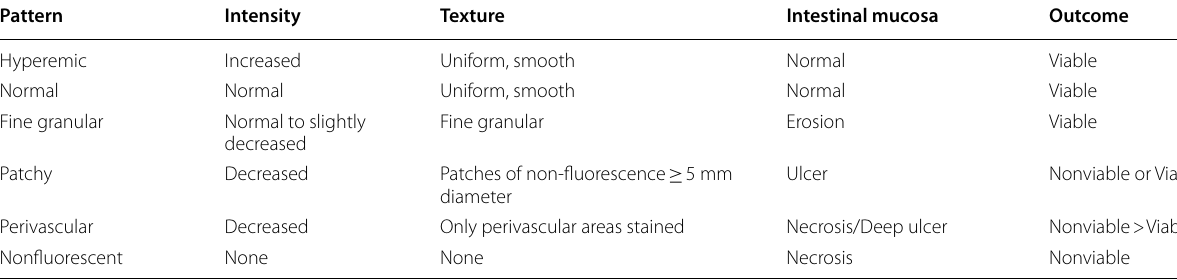
Table 1 Patterns of ICG fluorescence Pattern